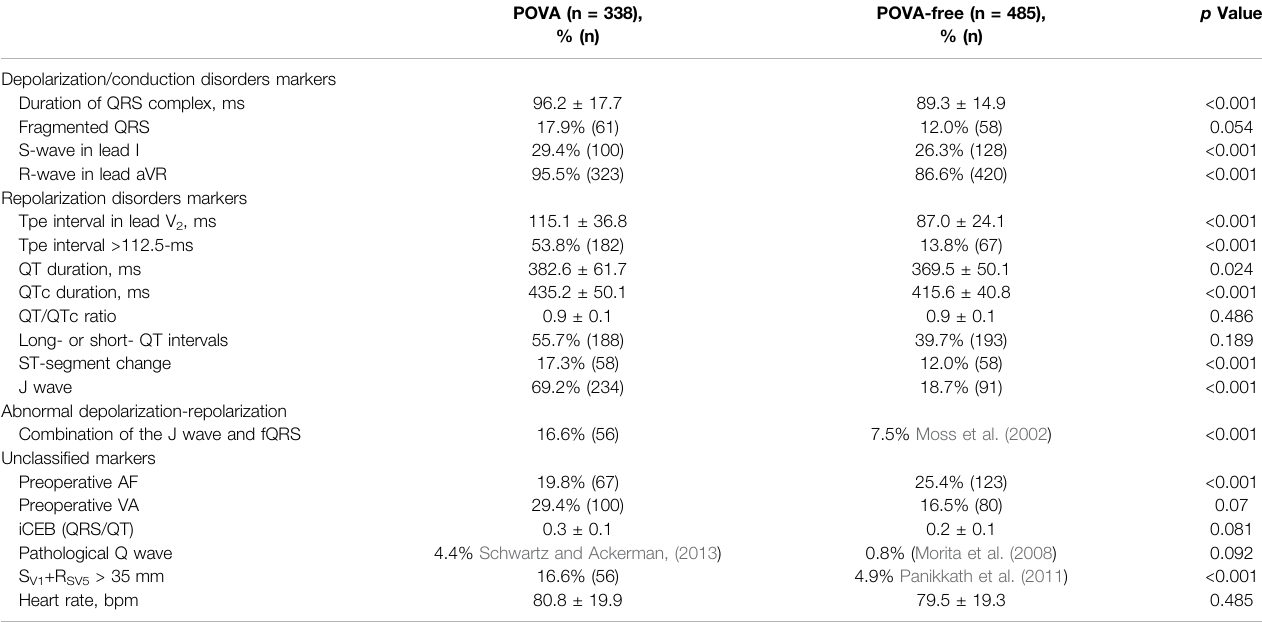
TABLE 2 | Preoperative electrocardiographic data in patients with POVA and POVA-free.